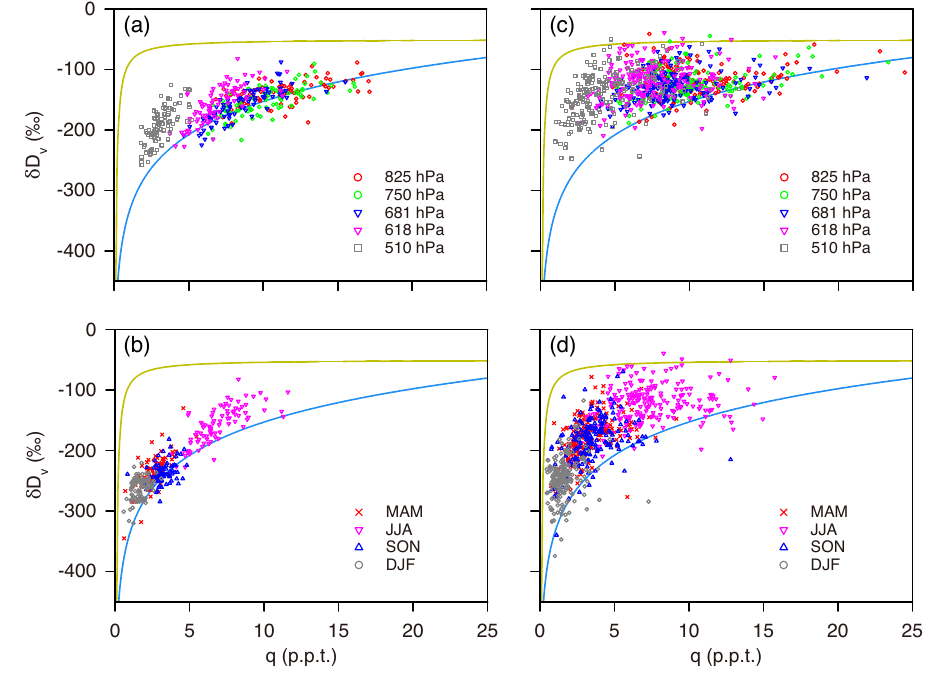
δ D − 80 ‰ at T =25 o C.Thesolidorangecurveineachpanelrepresentsthemixing v = line calculated for two isotopically distinctive air masses ( δ D v = − 450 ‰ and δ D v = − 80 ‰